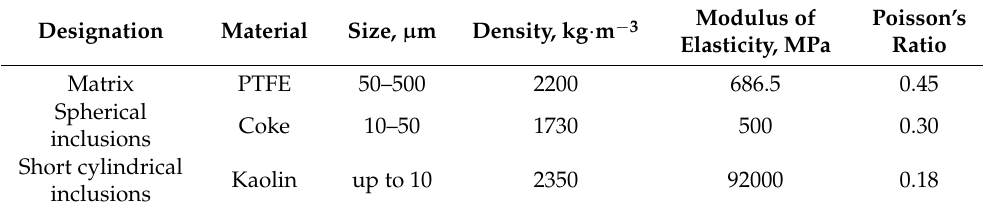
Table 1. Physical and mechanical properties of materials for research